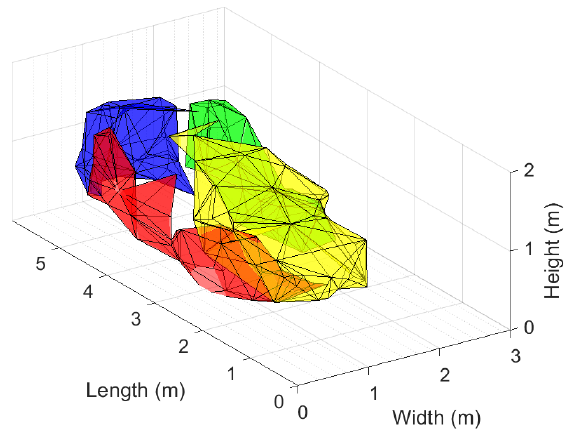
Figure 20. Delaunay triangulation surfacing the four sides of the